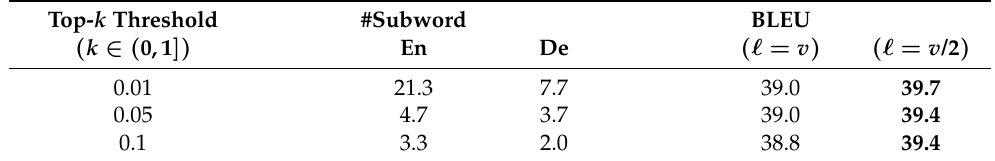
Table 3. Experimental results of LCP-dropout for News Commentary v16 (Table 2) with respect to the specified hyperparameters, where the translation task is De → En. Bold indicates the best score. Top- k